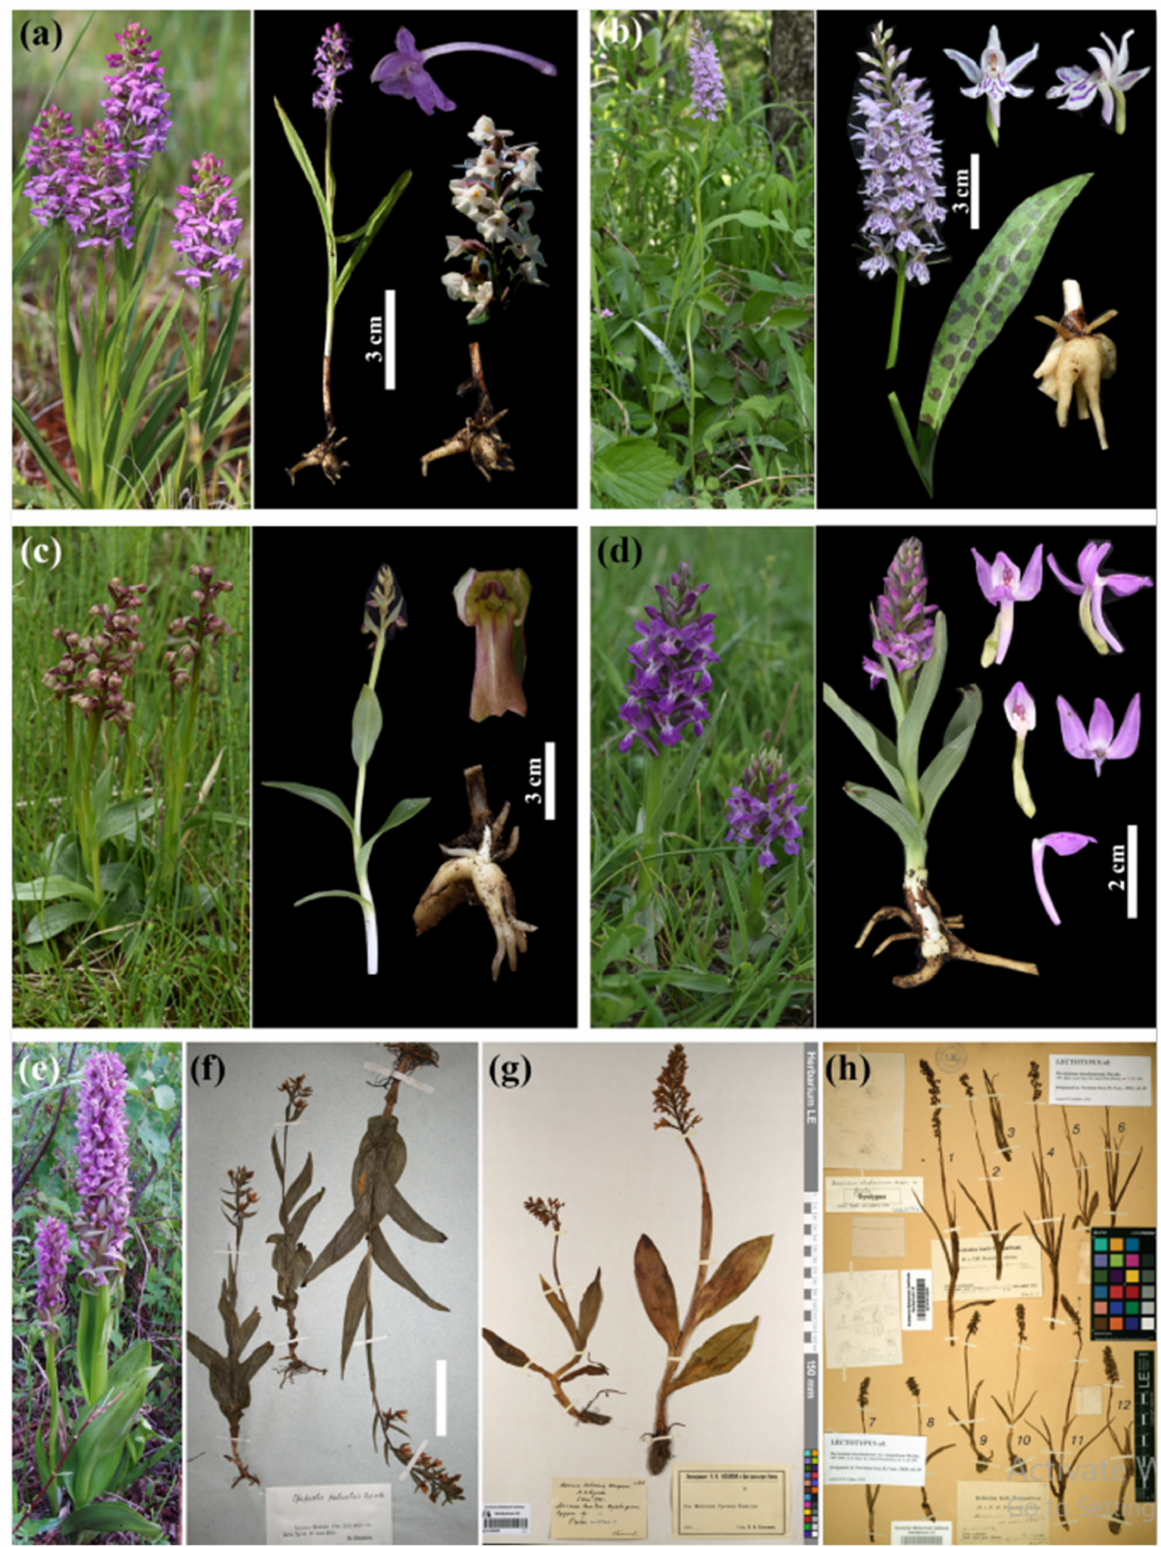
Figure 3. Representative taxa of Orchidaceae in Mongolia: ( a ) Gymnadenia conopsea, ( b ) Dactylorhiza fuchsii, ( c ) D. viridis, ( d ) D. umbrosa, ( e ) D. salina, ( f ) Epipactis palustris, ( g ) Orchis militaris, ( h ) Herminium alaschanicum (1–6, 11) and H. alaschanicum var. tanguticum (7–10, 12) (Photos: ( a – d ) by Sh. Baasanmunkh, ( e ) by Ch. Dulamsuren, ( f ) from T.K. and ( g , h ) from